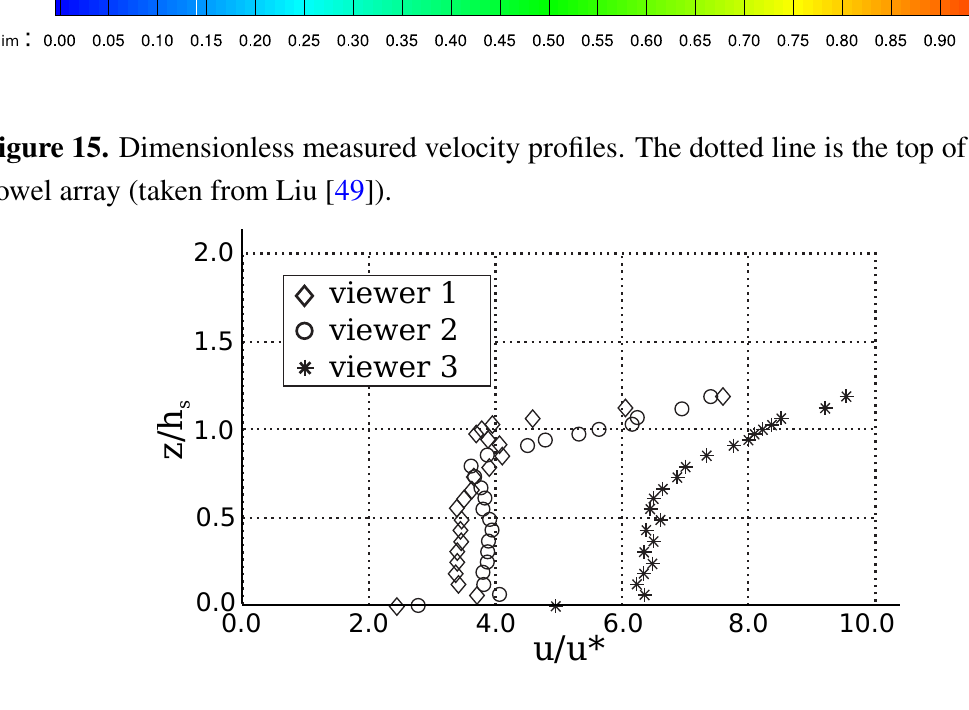
Figure 16. Comparison of the averaged experimental profile (triangles) and the predicted profile (continuous line) computed 3.55 m downstream from the beginning of the